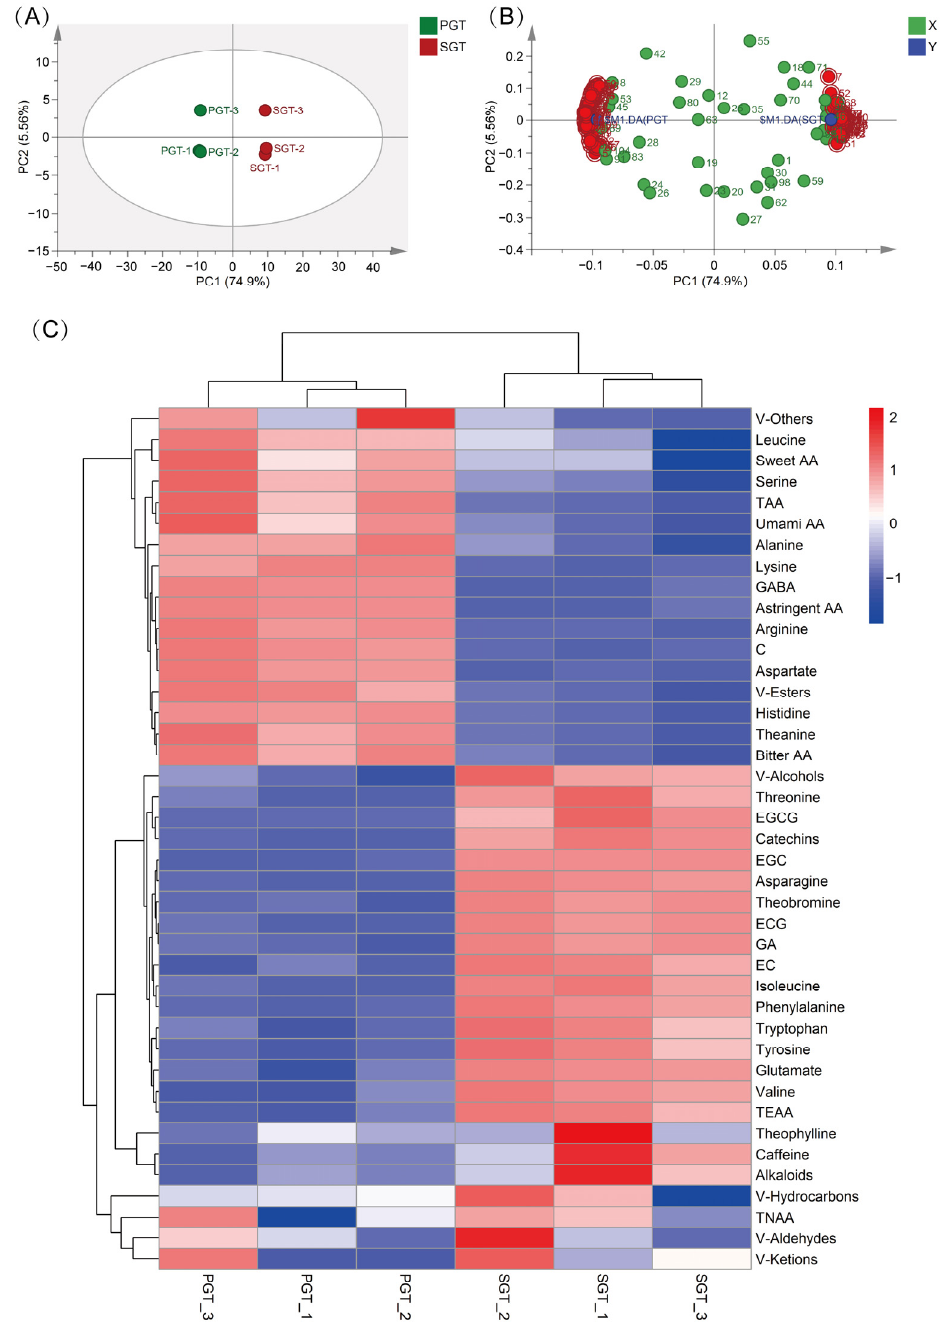
Figure 5. Comparison of PGT and SGT based on all biochemical compounds. ( A ) Score scatter plot of OPLS-DA analysis; ( B ) Loading scatter plot of OPLS-DA analysis; ( C ) Heatmap analysis. PGT, pan-fired green tea; SGT, steamed green tea; OPLS-DA, orthogonal partial least squares discriminant analysis; TAA, total amino acids; TEAA, total essential amino acids; TNEAA, total non-essential amino acids; Thea, theanine; GABA, γ -aminobutyric acid; GA, gallic acid; V-Alcohols, volatile alcohols; V-Aldehydes, volatile aldehydes; V-Ketones, volatile ketones; V-esters, volatile esters; V-Hydrocarbons, volatile hydrocarbons; V-Other, volatile others.